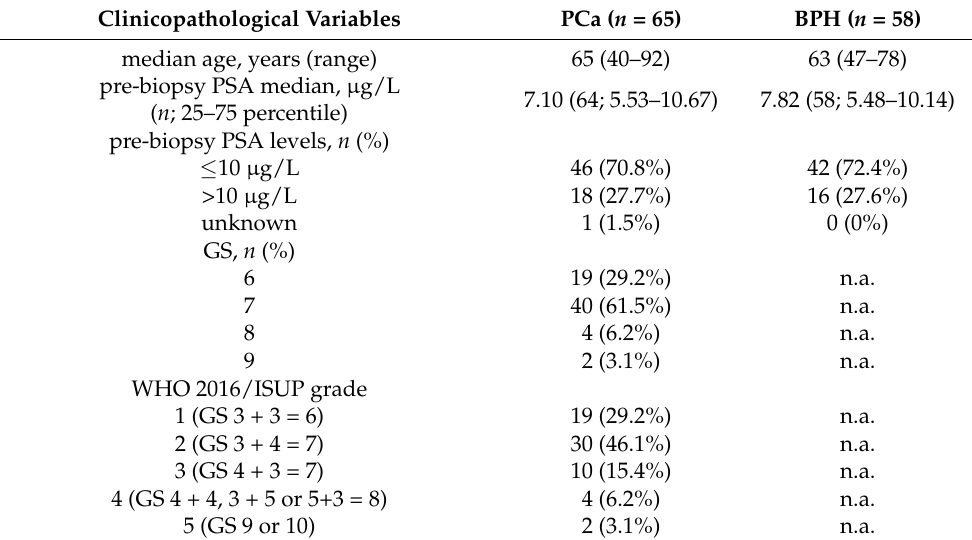
Table 1. Clinicopathological details of patients included in the study.